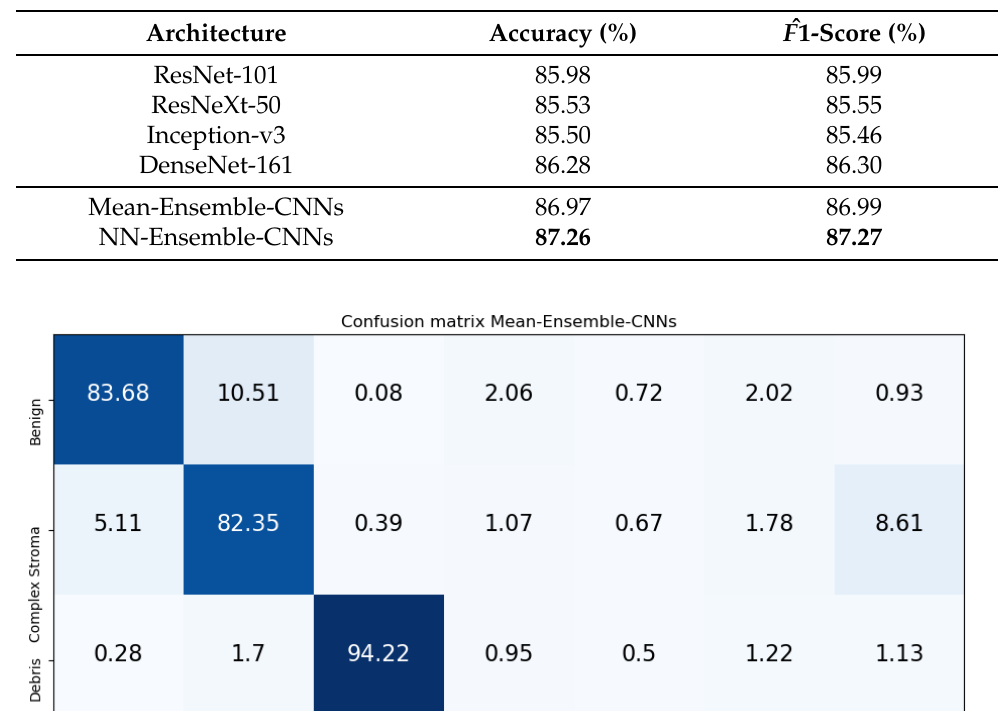
Table 5. Experimental results using ResNet-101, ResNeXt-50, Inception-v3, DenseNet-161, Mean- Ensemble-CNNs and NN-Ensemble-CNN on CRC-TP database.